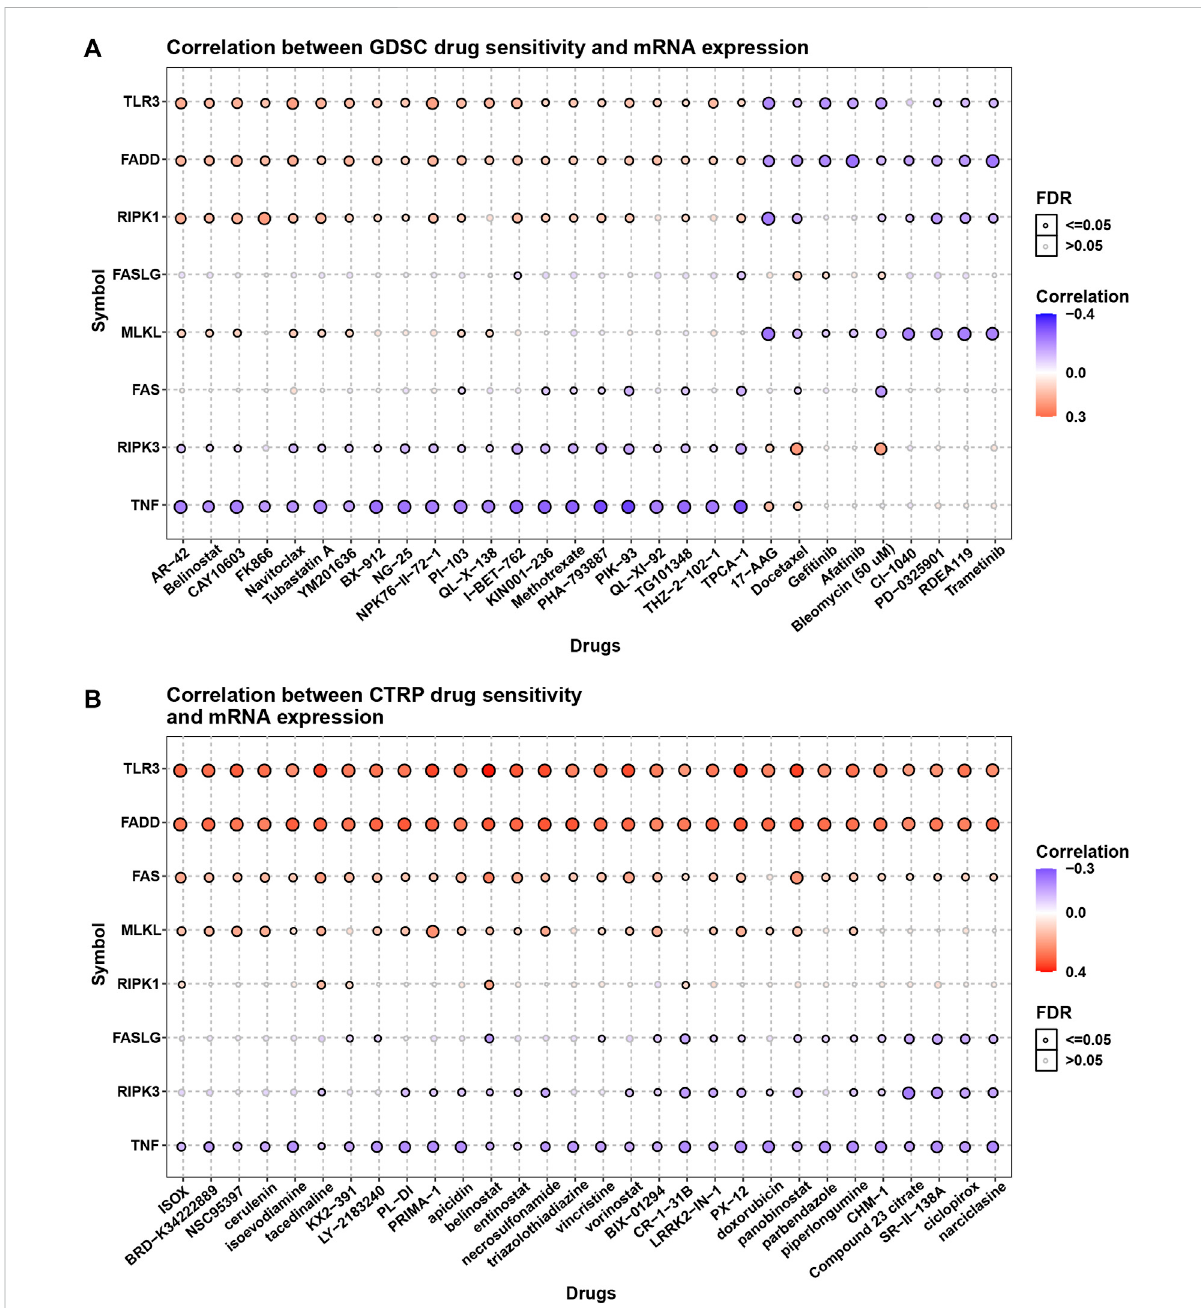
FIGURE 9 The association of necroptosis genes with ef fi ciency of anti-tumor drugs. (A) The correlation between necroptosis score and IC50 of anti- tumor drugs based on GDSC database. (B) The correlation between necroptosis score and IC50 of anti-tumor drugs based on CTRP database.